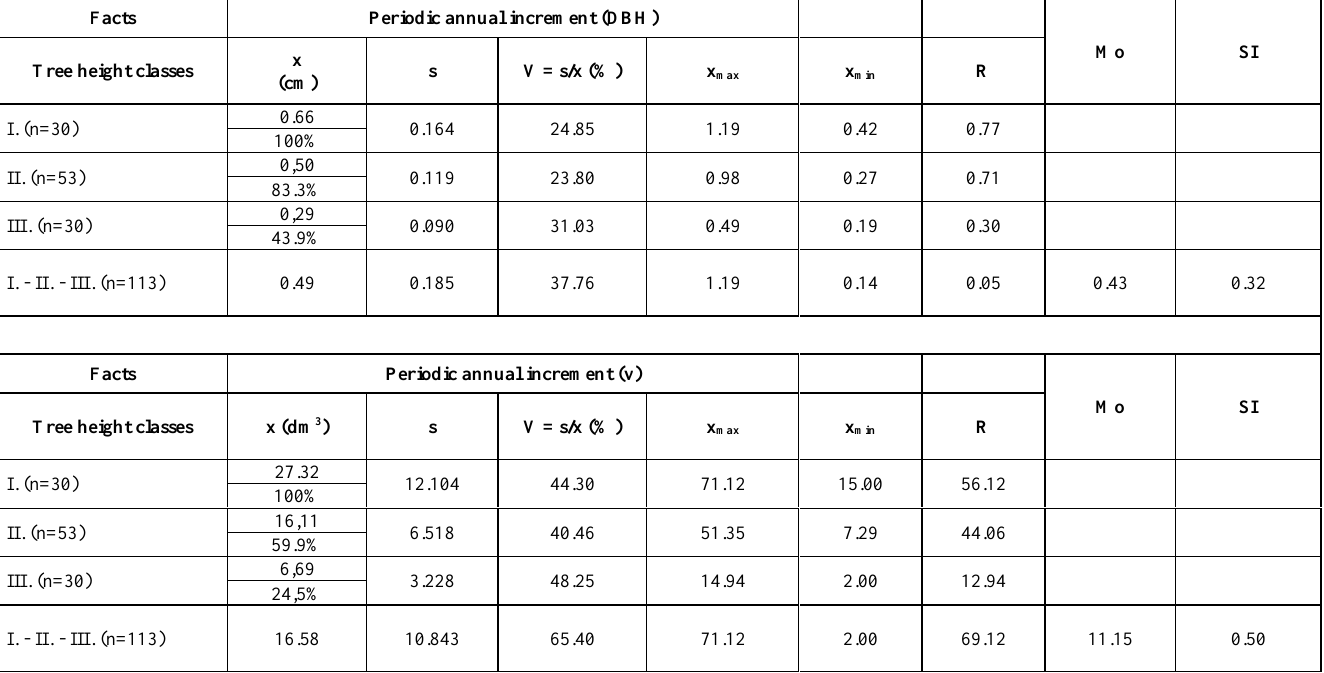
Table 2. Mathematical-statistical indicators of periodic annual increments (Pusztavacs 215 E)